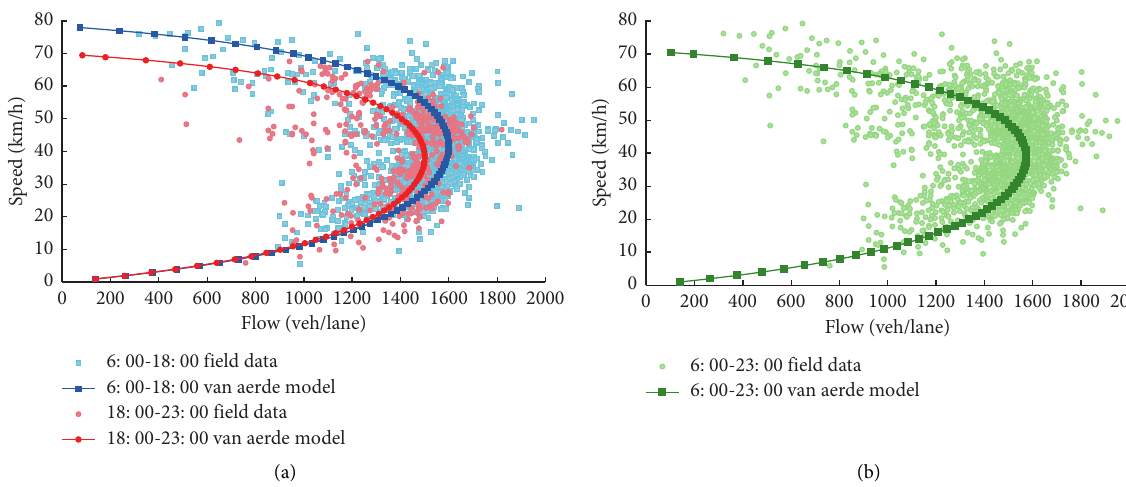
Figure 2: The flow-speed fundamental diagram of different times for the second ring expressway in Beijing. (a) Multiperiod model of the fundamental diagram. (b) All-day model of the fundamental diagram. Table 1: Four parameters of the Van Aerdel model at different times are calibrated by the regression. Time